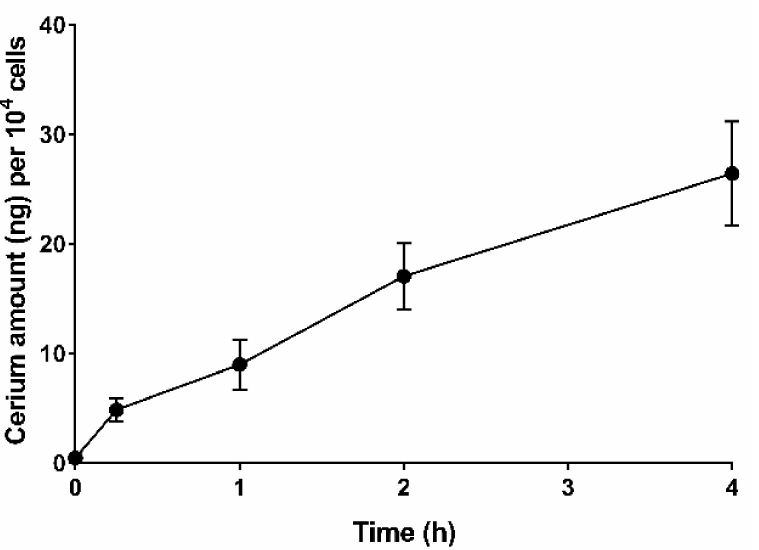
Figure 1. Time-dependent uptake of EGCNPs in HLECs. HLECs were incubated with EGCNPs for 0 and 15 min and 1, 2, and 4 h and the level of internalised cerium in the cells was measured by ICP-MS. The experiments were run in triplicate for each time point and the data are expressed as mean ± standard deviation